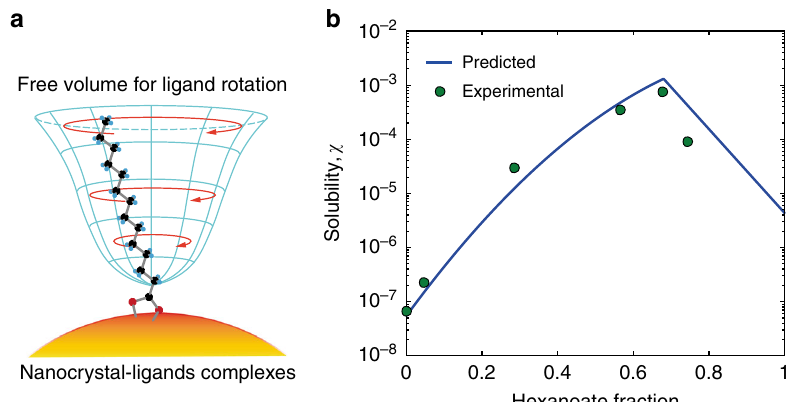
Fig. 5 Predicting ligand interaction energy and solubility. a Graphical illustration of the geometric con fi nement of a fl exible surface ligand in the dispersive energy force fi eld. b The predicted solubility at room temperature (blue solid line) and the experimental values measured in chloroform based on ultraviolet absorbance (green